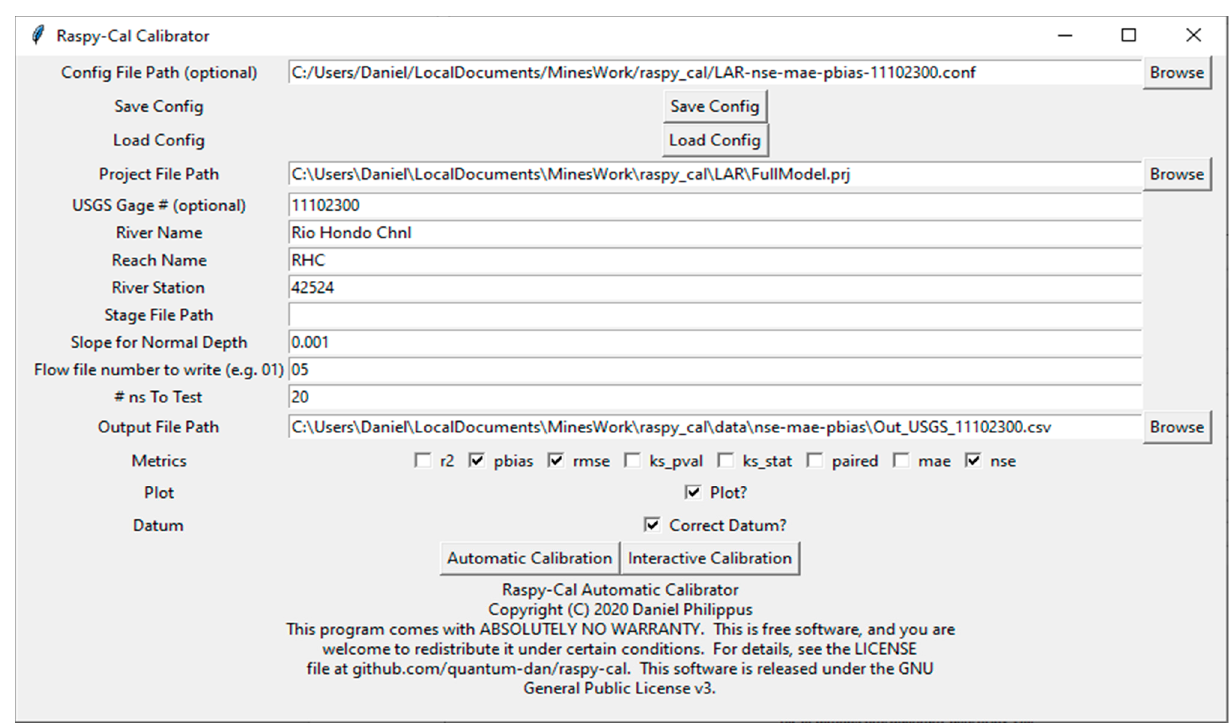
Figure 5. Raspy-Cal graphical user interface. Note that settings are specific to the given calibration reach. Also note that the calibration river station must be a cross-section, not a hydraulic structure.